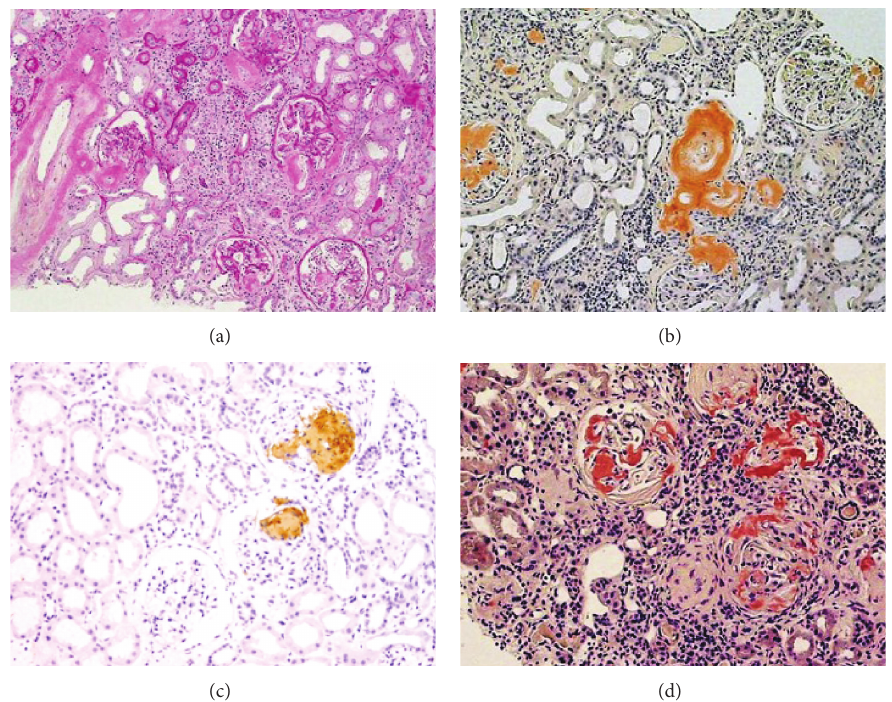
Figure 3: Renal biopsy. (a) Hematoxylin-eosin staining shows that approximately 40% of the glomeruli were globally sclerotic; however, the remaining glomeruli were minimally obliterated by mesangial matrix expansion, and homogeneous and eosinophilic deposits were evident along the capillary walls. Small arteries are thickened by eosinophilic deposits, and tubules are focally atrophic. (b) The deposits reveal positive reactions to Congo red. (c) Immunoperoxidase staining confirmed that the deposits included amyloid A protein. (d) After 4 years of tocilizumab treatments, Congo red staining revealed no regression of the amyloid deposition.